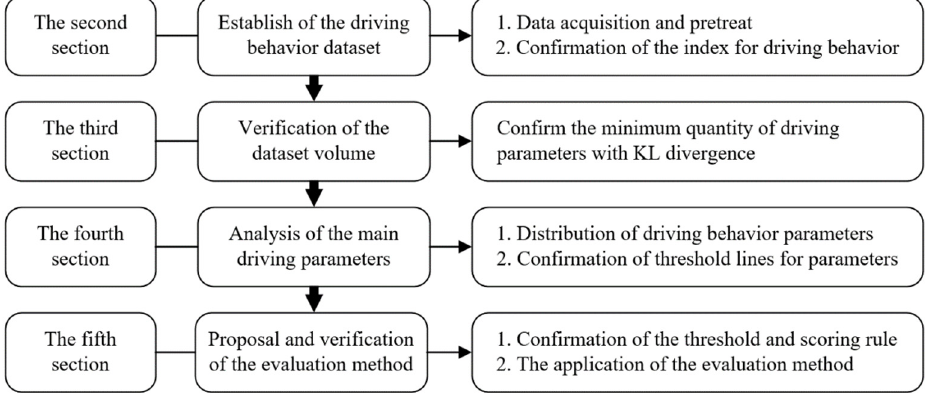
Figure 1. The main study flow chart.